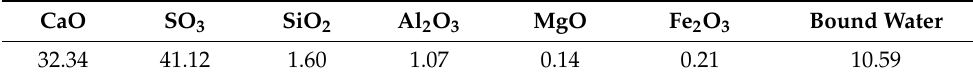
Table 3. Main chemical compositions of FGDG/wt.%.